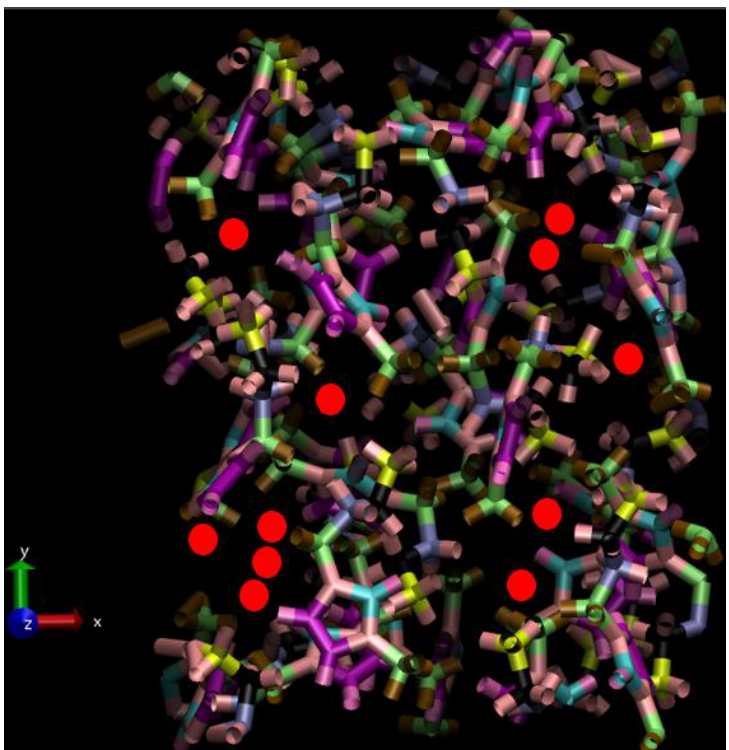
Figure 6. Representation of a typical liquid-phase configuration, alongside the laboratory Cartesian axes (with the z-axis perpendicular to the page); selected iodine anions are depicted as red spheres with their approximate ionic radius, and the cations are depicted in terms of their covalent-bonding motifs, in a “packed” manner across PBC simulation-box boundaries. Some of the shown iodine ions in the upper z-axis part of the simulation box are ‘poised’ in a pre-reactive configuration, ready for subsequent bond-exchange interaction.